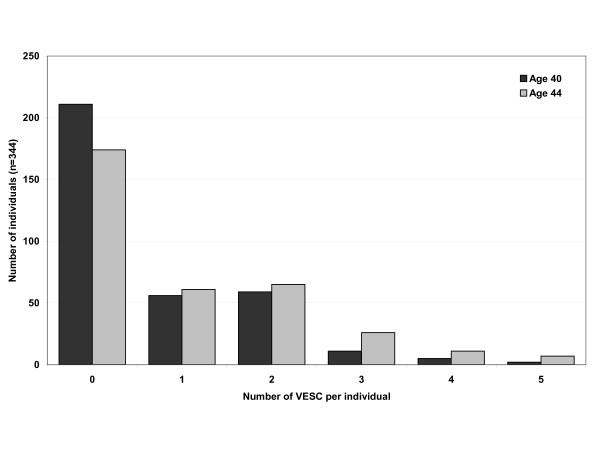
VESC per person. The number of VESC per person at age 40 and 44 in persons from the Danish general population (n = 344).